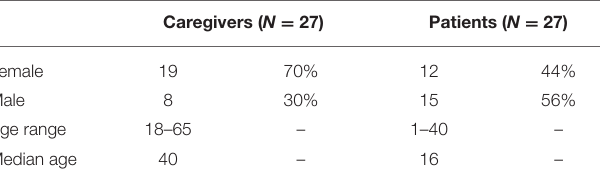
TABLE 1 | Gender and age details of participant caregivers and related patients. Caregivers ( N = 27) Patients ( N =